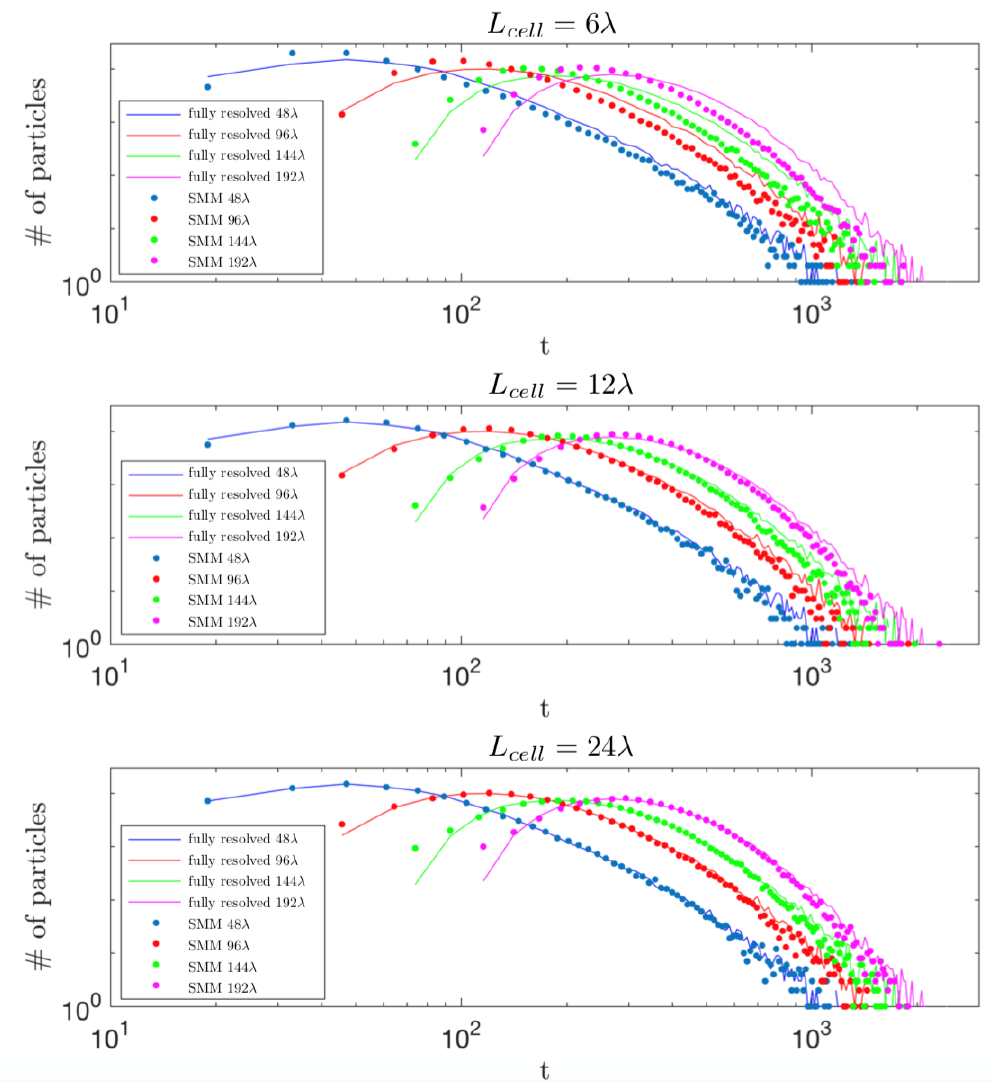
Figure 5. Breakthrough curves measured at distances 48 λ , 96 λ , 144 λ , and 192 λ downstream from the inlet for both the fully resolved model (solid lines) and the Spatial Markov model (dotted lines) with cell lengths of ( top ) 6 λ , ( middle ) 12 λ , and ( bottom ) 24 λ . From these results, it was determined that a cell length of 24 λ was an appropriate choice for our upscaled